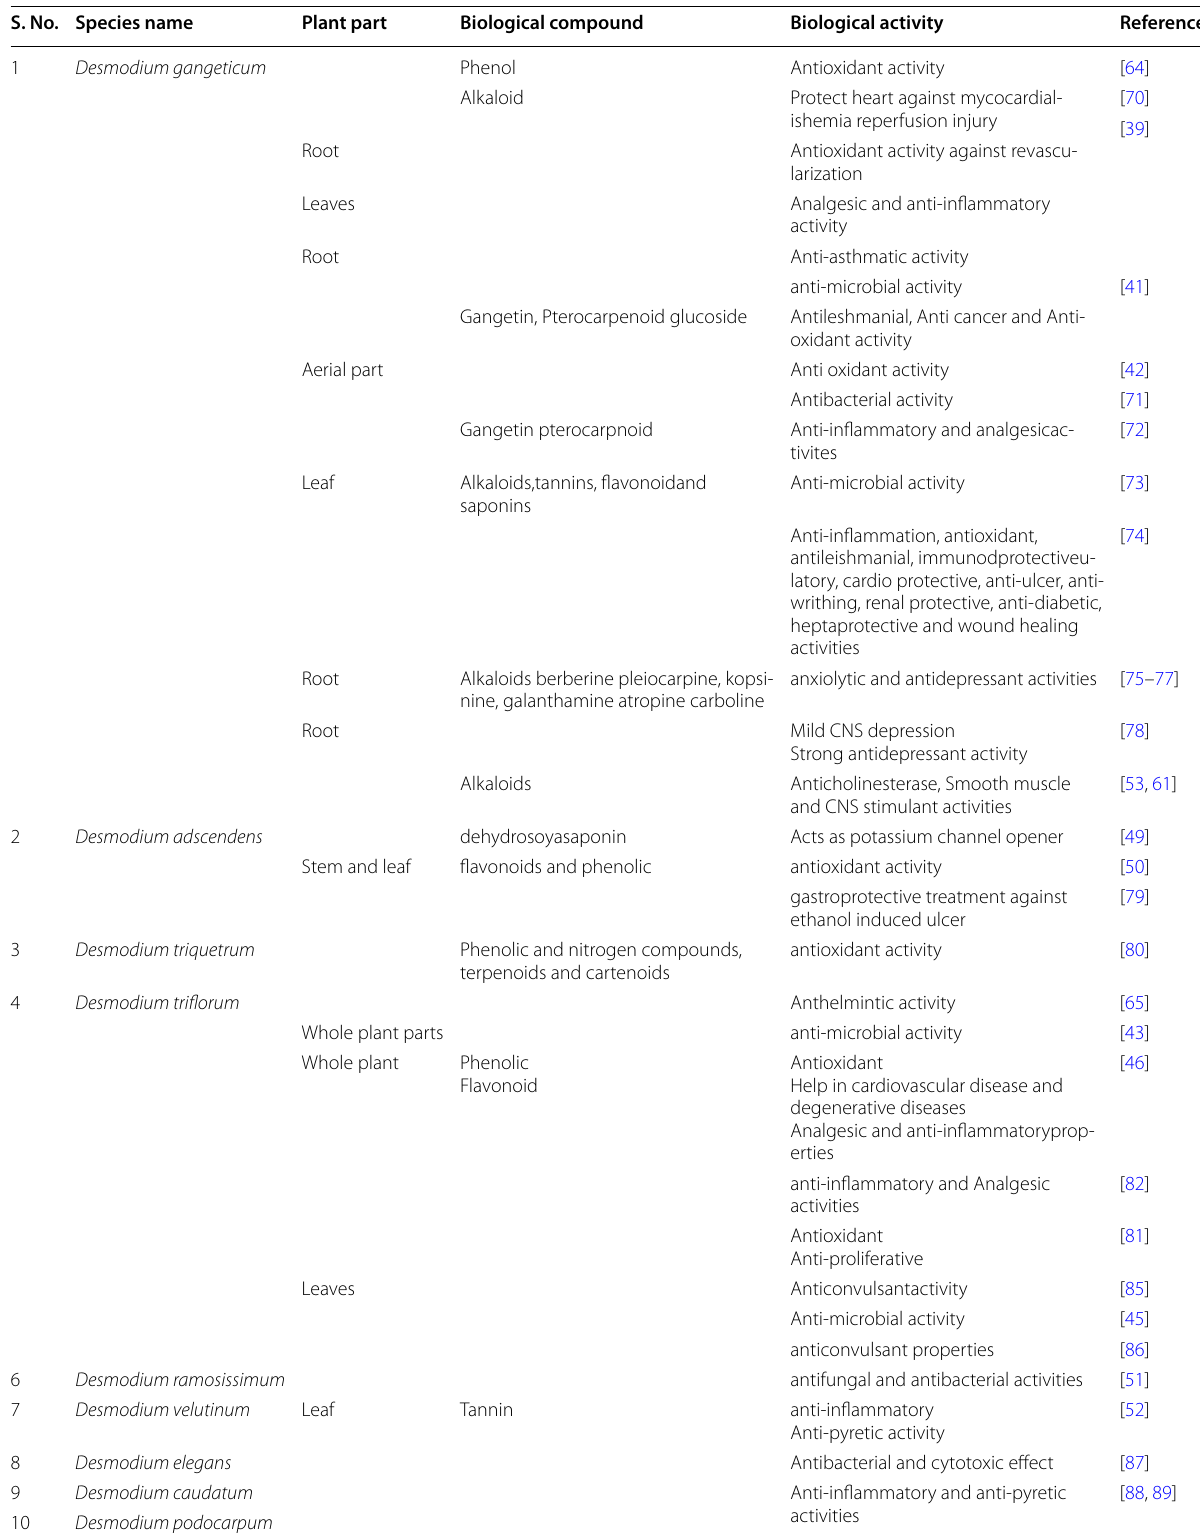
Table 2 biologicalactivities of Desmodium species S. No. Species